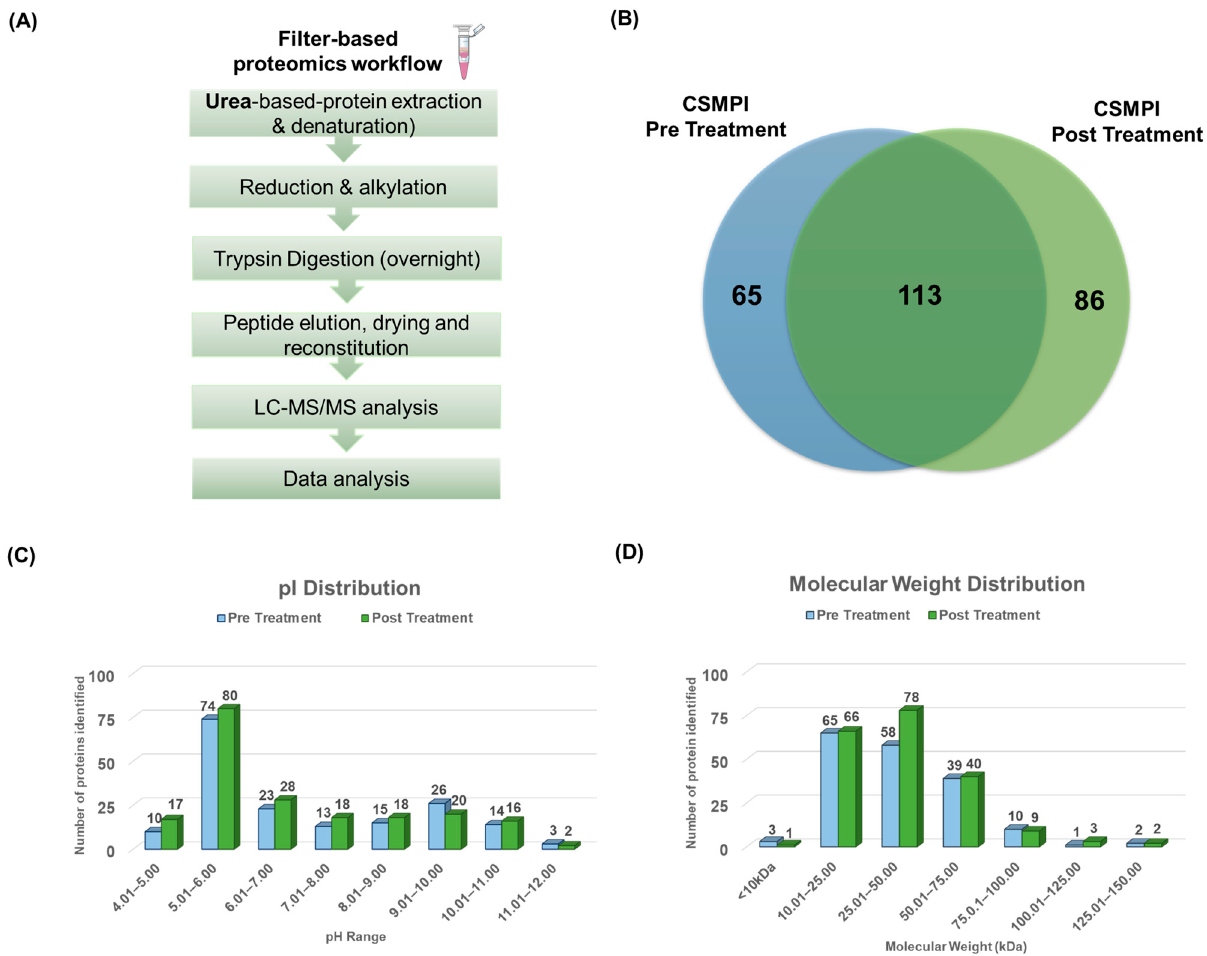
Figure 2. LC-MS/MS analysis of pre-treated and post-treated CSMPI. ( A ) A filter-based proteomics workflow was applied to generate tryptic peptides from CSMPI for LC-MS/MS analysis. ( B ) Venn diagram illustrating the number of common and unique proteins identified in each CSMPI dataset. ( C ) pI distribution of identified proteins from pre-treated and post-treated CSMPI. ( D ) Molecular- weight distribution of identified proteins from pre-treated and post-treated CSMPI.